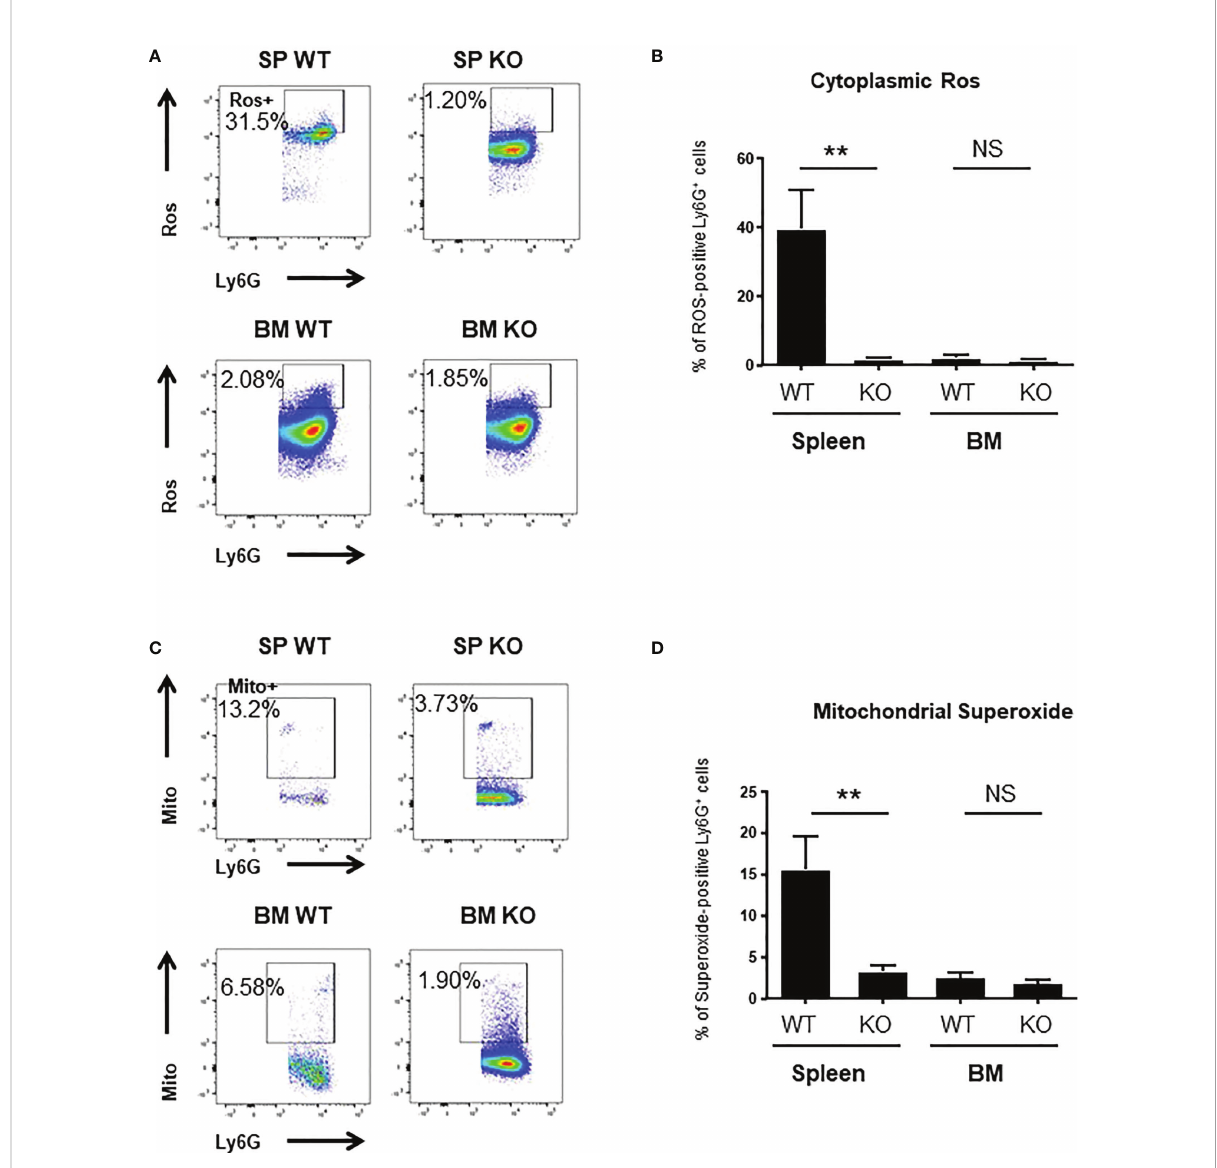
FIGURE 3 spleen Cxcr2-/- neutrophils display reduced ROS and superoxide levels. (A) Gating strategy to measure cytoplasmic Ros levels using CellRox Orange in CD11b+ Ly6G+ neutrophils. (B) ROS levels were quanti fi ed in spleen and BM CD11b+ Ly6G+ neutrophils using CellRox Orange probe. Results are expressed as the percentage of ROS-positive neutrophils in the CD11b+ Ly6G+ population and represent the mean ± SEM of at least 6 animals (Mann-Whitney test, NS: non-signi fi cant, **p < 0.01). (C) Gating strategy to measure Mitochondrial superoxide levels using Mitosox in CD11b+ Ly6G+ neutrophils. (D) Measure of the percentage of mitochondrial superoxide – positive CD11b+ Ly6G+ neutrophils using Mitosox reagent. Data represent the mean ± SEM of at least 6 animals (Mann-Whitney test, NS: non-signi fi cant, **p <